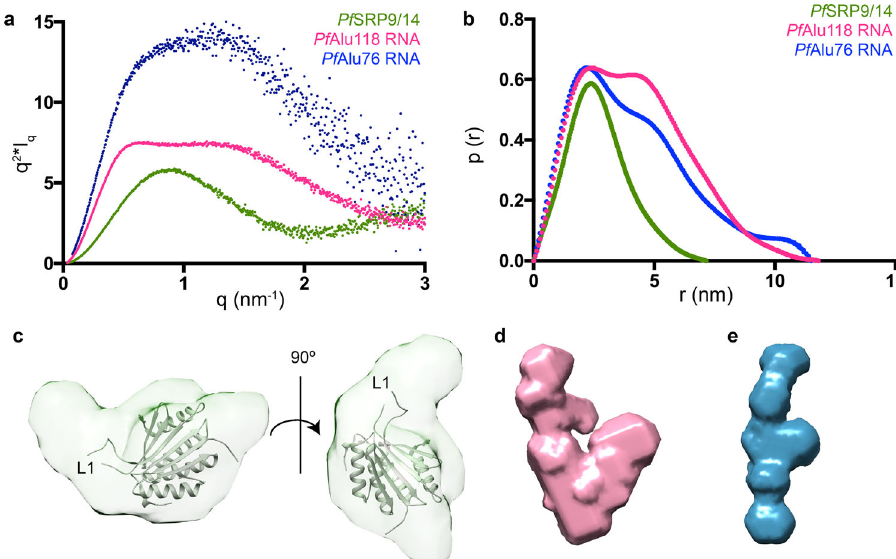
Fig. 4 SAXS analyses of the P. falciparum Alu domain protein and RNA components. a Kratky plots and b p(r) curves of the Pf SRP9/14 heterodimer (green), Pf Alu118 RNA (magenta), and Pf Alu76 RNA (blue) are presented. c Ab initio model of Pf SRP9/14 superposed with the crystal structure of Hs SRP9/14 (PDB: 4UYK) 27 . The position of loop L1 is marked. d , e show ab initio models of Pf Alu118 and Pf Alu76 RNA,